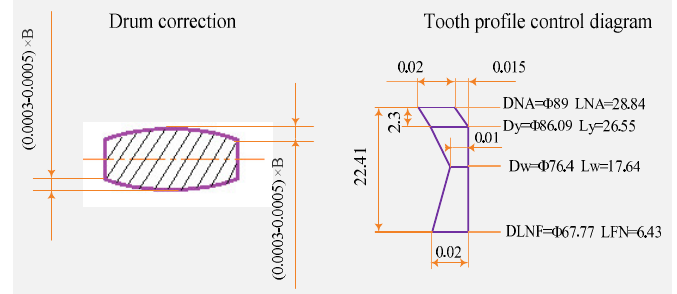
Figure 12. Gear repair requirements.